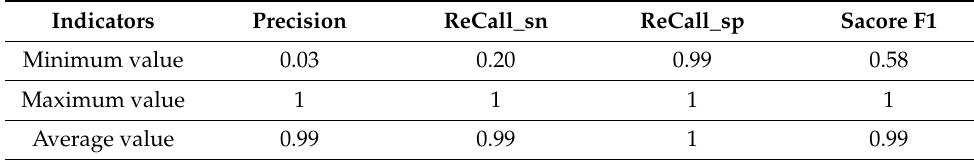
Table 7. Experimental results under different evaluation indexes.